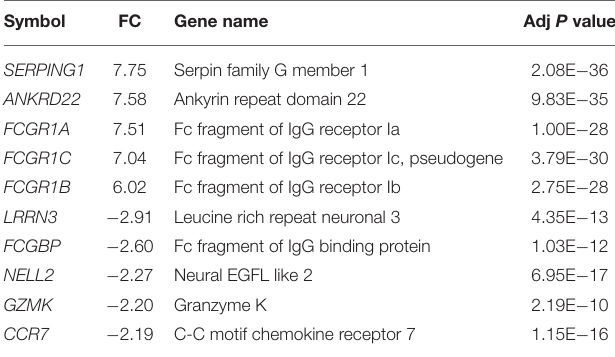
TABLE 1 | The top 10 differentially expressed gene list in pulmonary tuberculosis